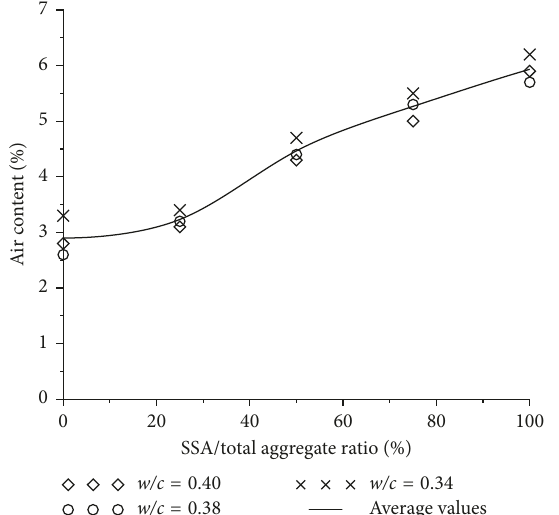
Figure 10: Relationship between the SSA replacement ratio and air content.